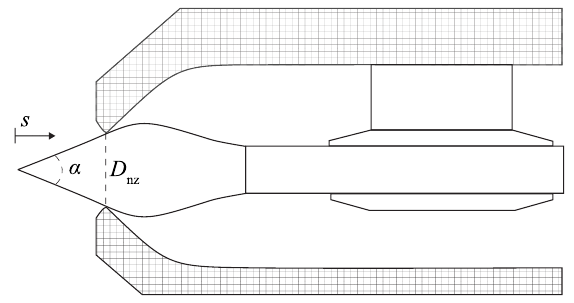
Figure 8. Cross section of the spear valve used. The coning angle of the spear is given by α , the nozzle diameter by D nz , and the position of the spear tip in the nozzle by s . The nozzle heads are adjustable for the adjustment of the outlet